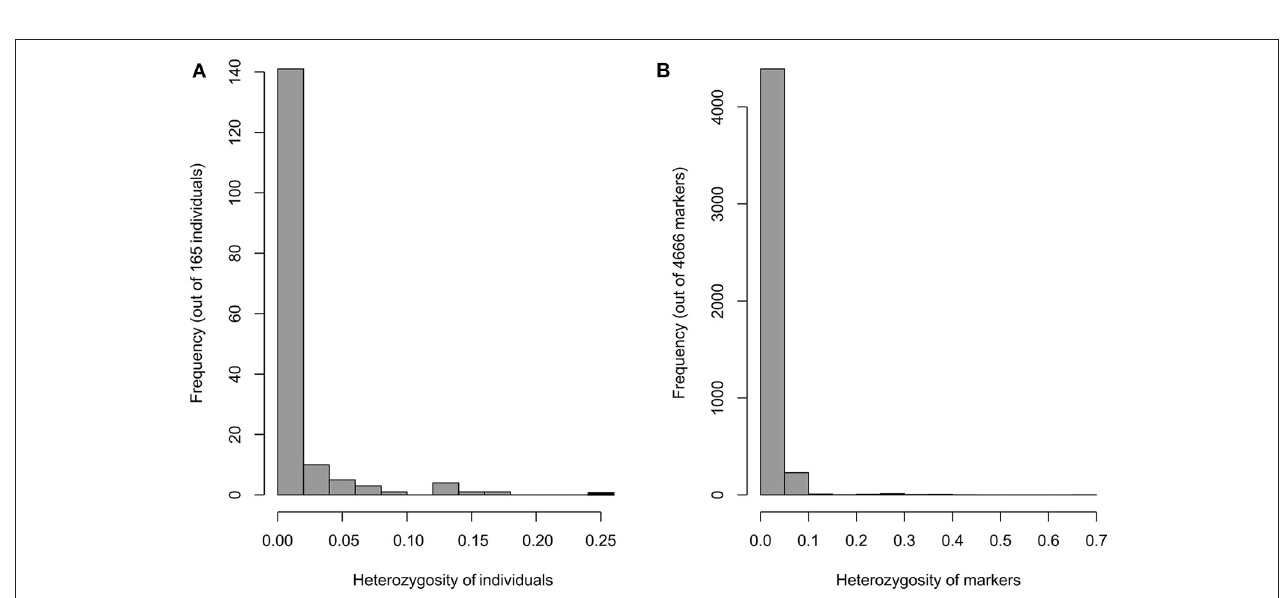
FIGURE 3 | Heterozygosity 4666 SNP markers in the 165 inbred lines. (A) Heterozygosity of individuals. (B) Heterozygosity of markers.